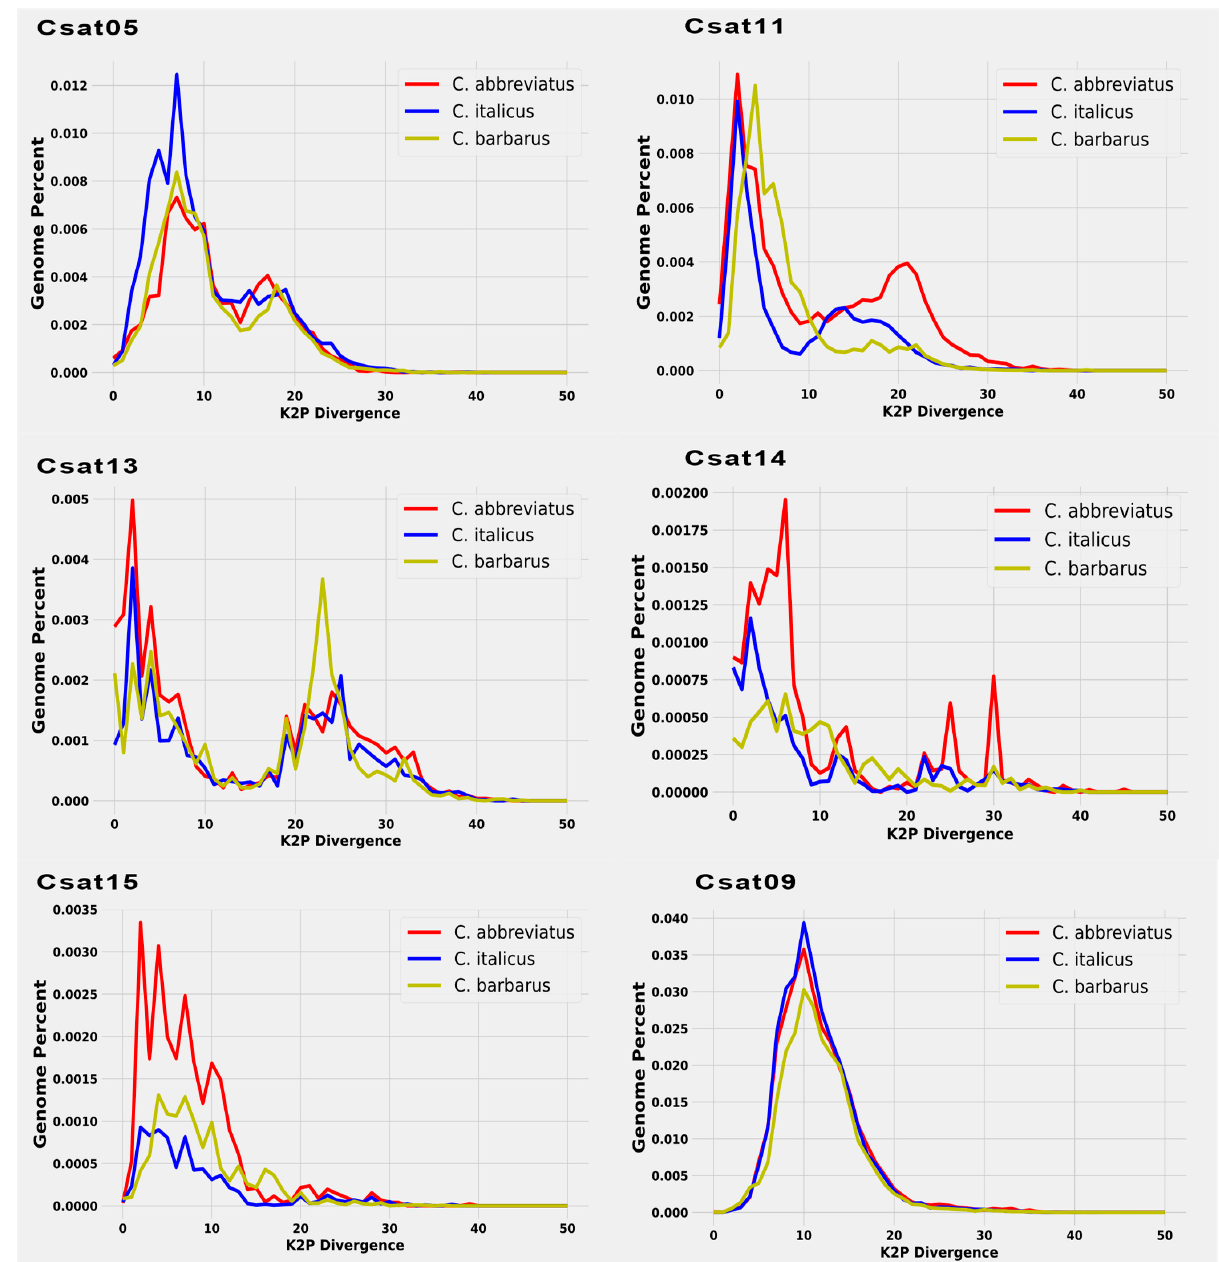
Figure 4. A comparative repeat line graph for each satDNA family revealed a two-peak pattern of divergent monomer sequences from consensus sequences across three species genomes. A satellite DNA family was highly conserved among the three species of the genus Calliptamus (CSat09).